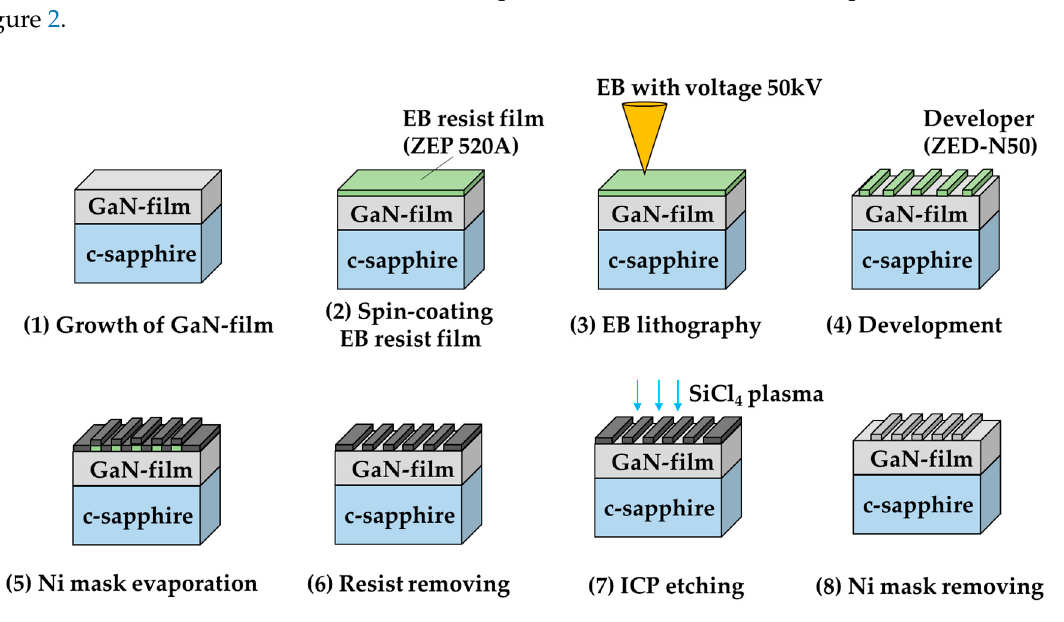
Figure 2. Fabrication protocol of the GaN-HCG.